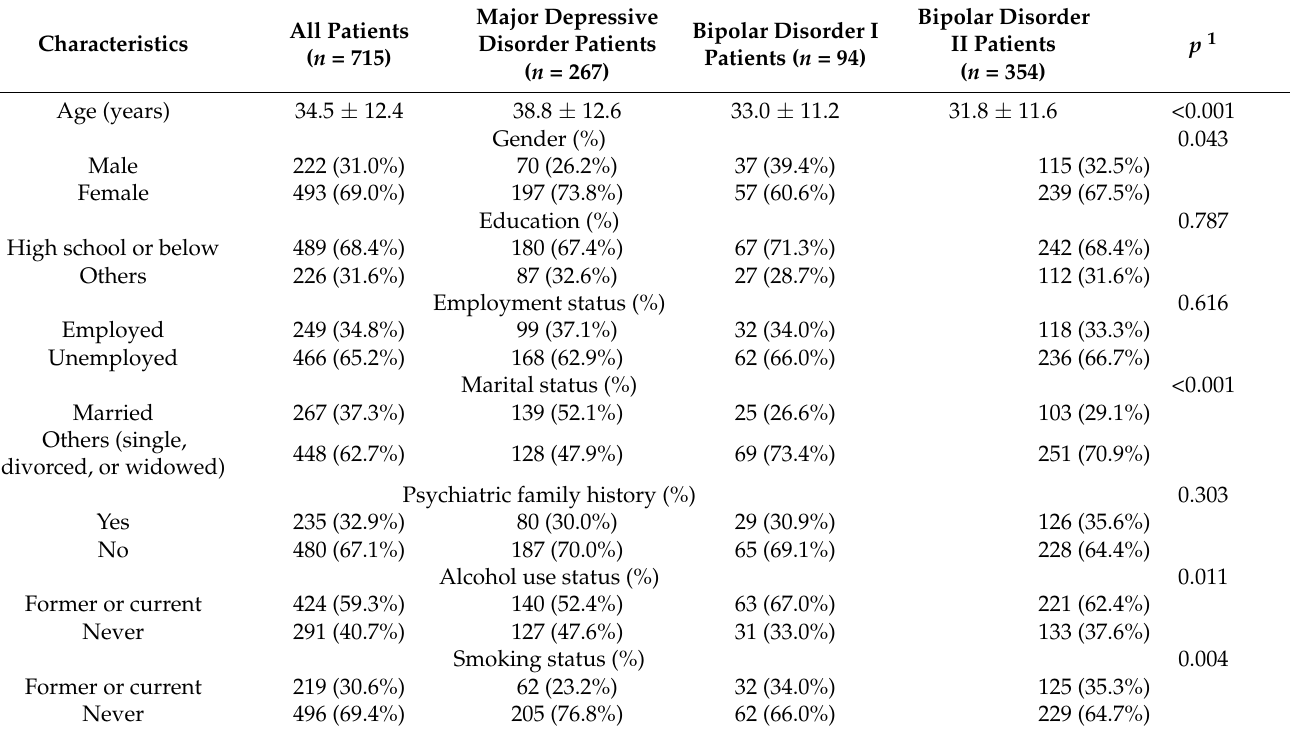
Table 1. Participants’ demographic and clinical features ( n =